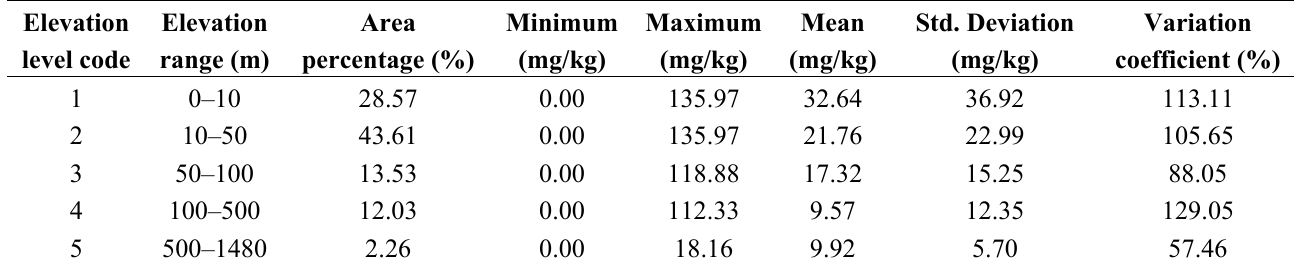
Table 6. Summary statistics of soil available phosphorus of different elevation levels.